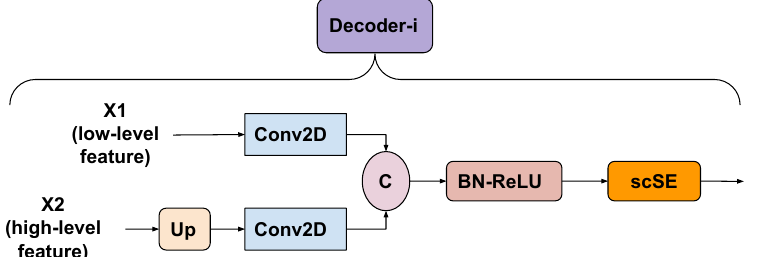
Figure 9. Decoder block of the